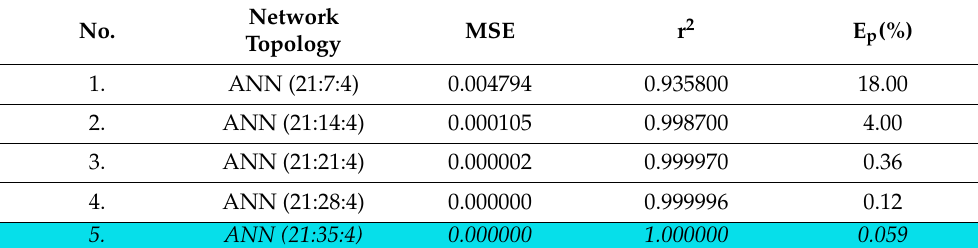
Table 2. Different types of ANN tested and their performance in the training stage.